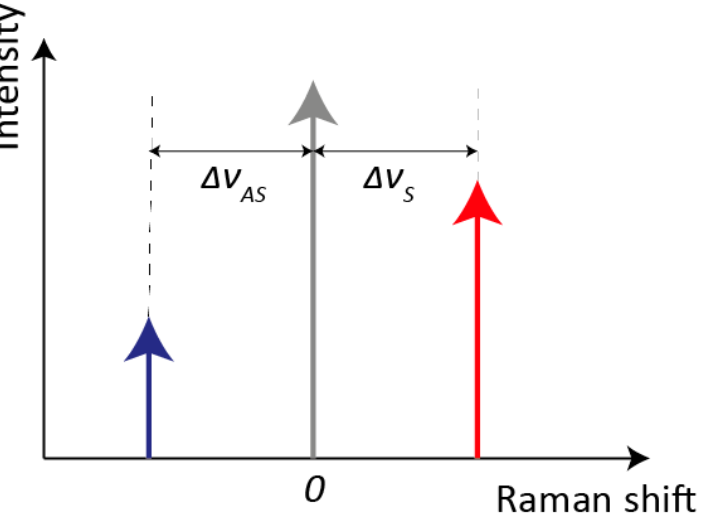
Figure 2. Schematic representation of Raman shifts for Stokes and anti-Stokes processes. The red and blue arrows represent, respectively, the intensities of Stokes and anti-Stokes Raman scattering, whereas the grey arrow represents the Rayleigh scattering (not in scale).